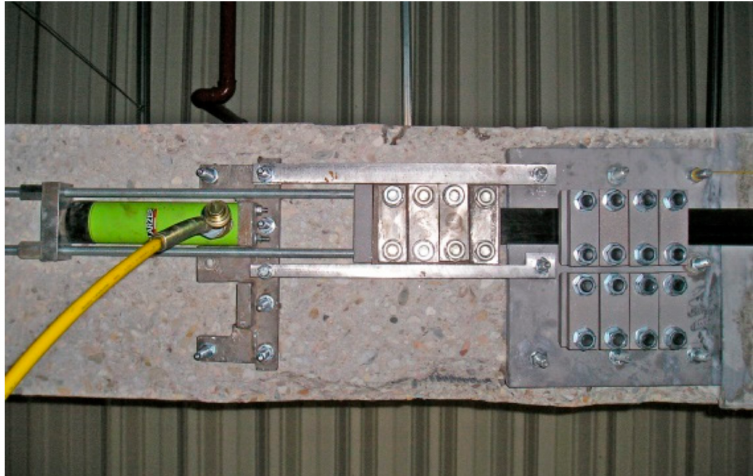
Figure 4. View of live